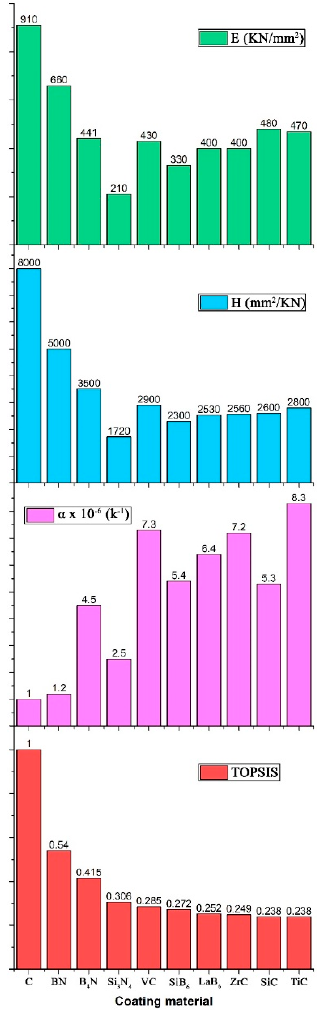
Figure 19. The E, H, α , and TOPSIS values of the top ten ranked coating materials.